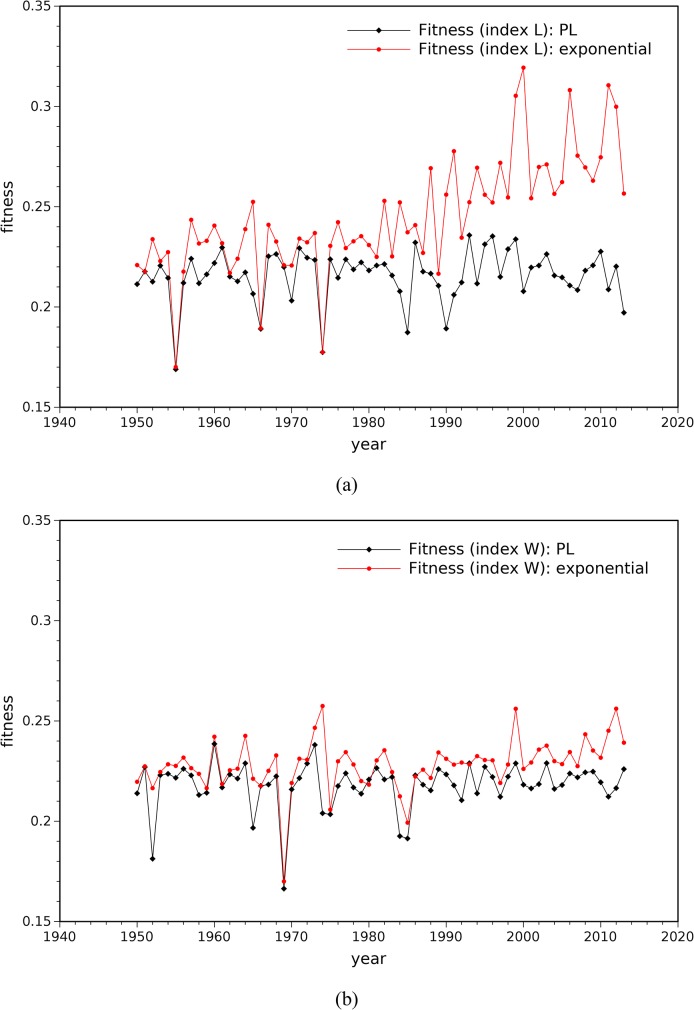
Fitness function values obtained for the PL and the exponential models: (a) tornado path length index, L; (b) tornado width index, W.